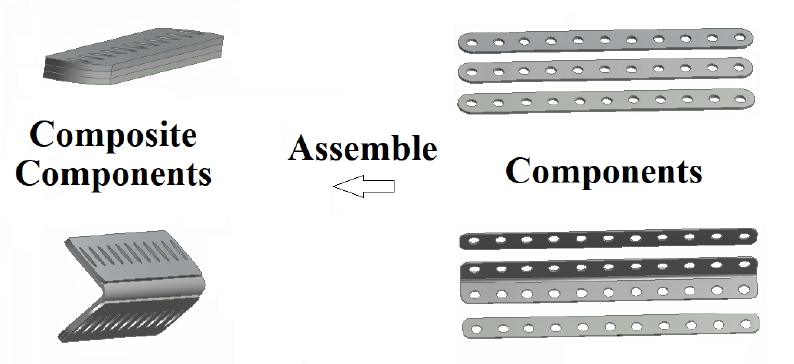
Figure 6. Assembly of components into composite